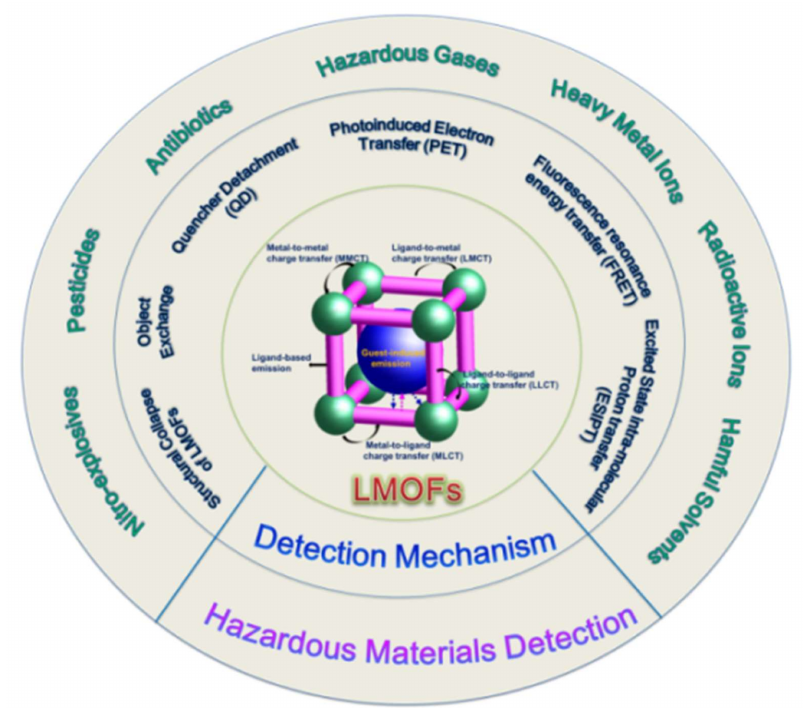
Figure 1. Schematic illustration of emission modes, detection mechanisms, and the applications of MOF-based fluorescent sensors for hazardous materials